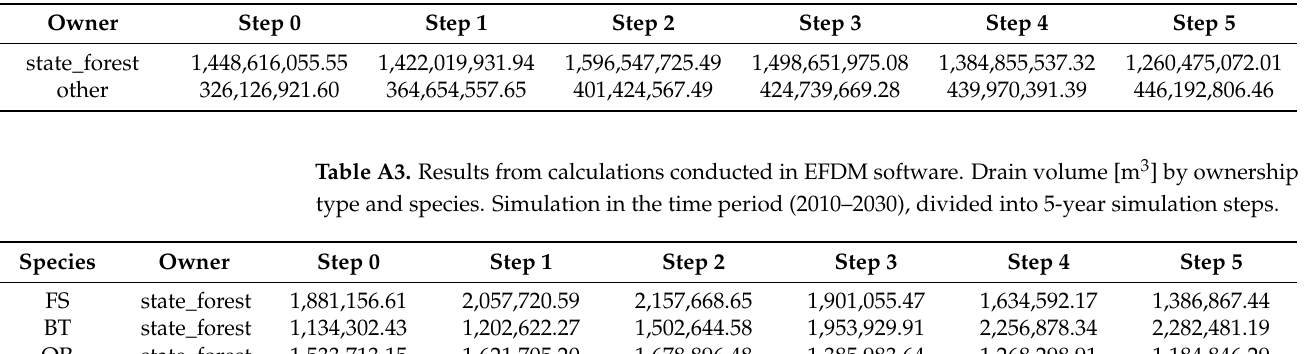
Table A2. Results from calculations conducted in EFDM software. Volume [m 3 ] aggregated by